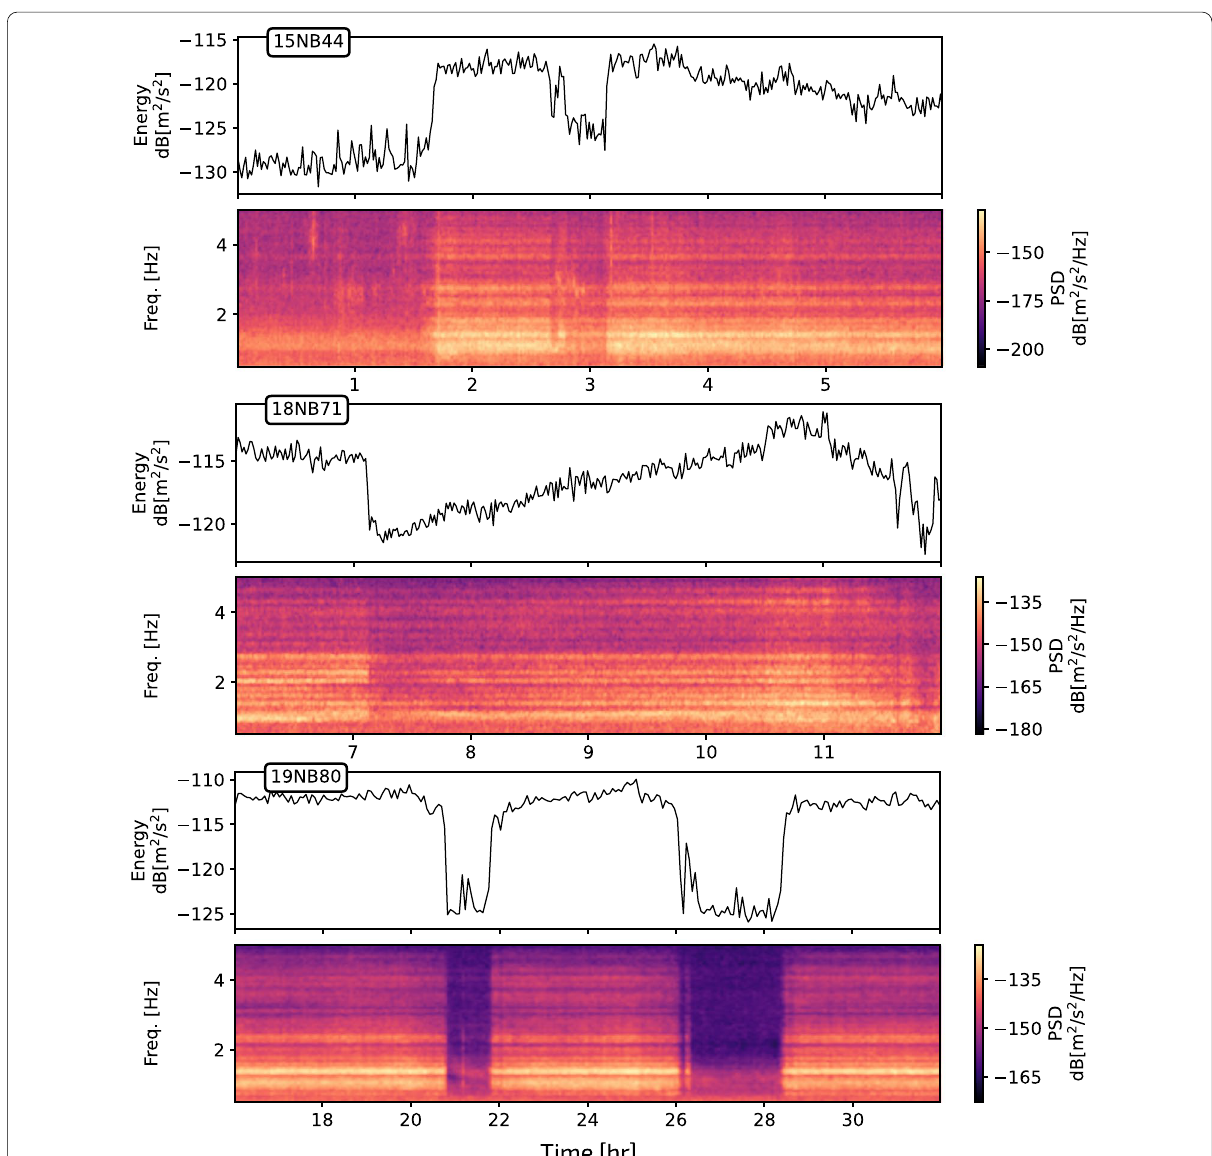
Fig. 6 Examples of “seismic silences” during long-duration NB tremors. The attributes of these tremors can de documented in Additional file 1 by searching for the codes shown at the top left of each